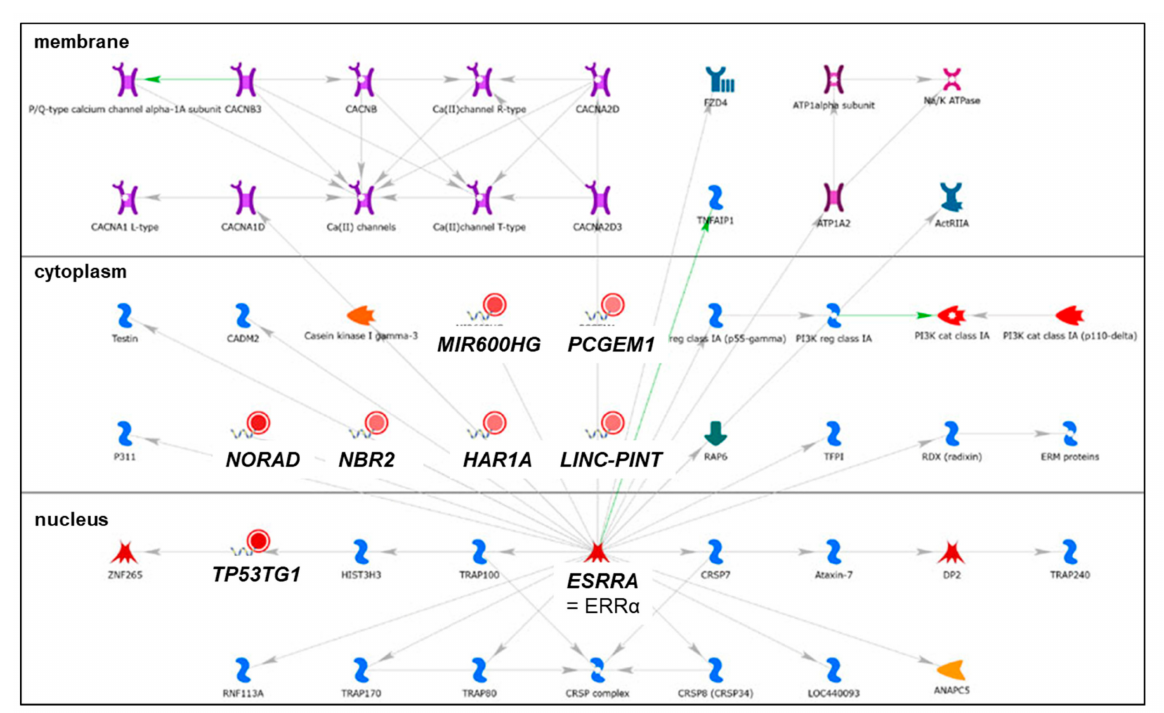
Figure 9. Network 1: LOC647979 ( NORAD ), NBR2, PCGEM1, LINC-PINT, and MIR600HG , identified in lncRNAs differen- tially expressed in MCF-7 and or LCC9 cells by MetaCore analysis. Green lines with arrows = stimulation; red lines with arrows = inhibition.